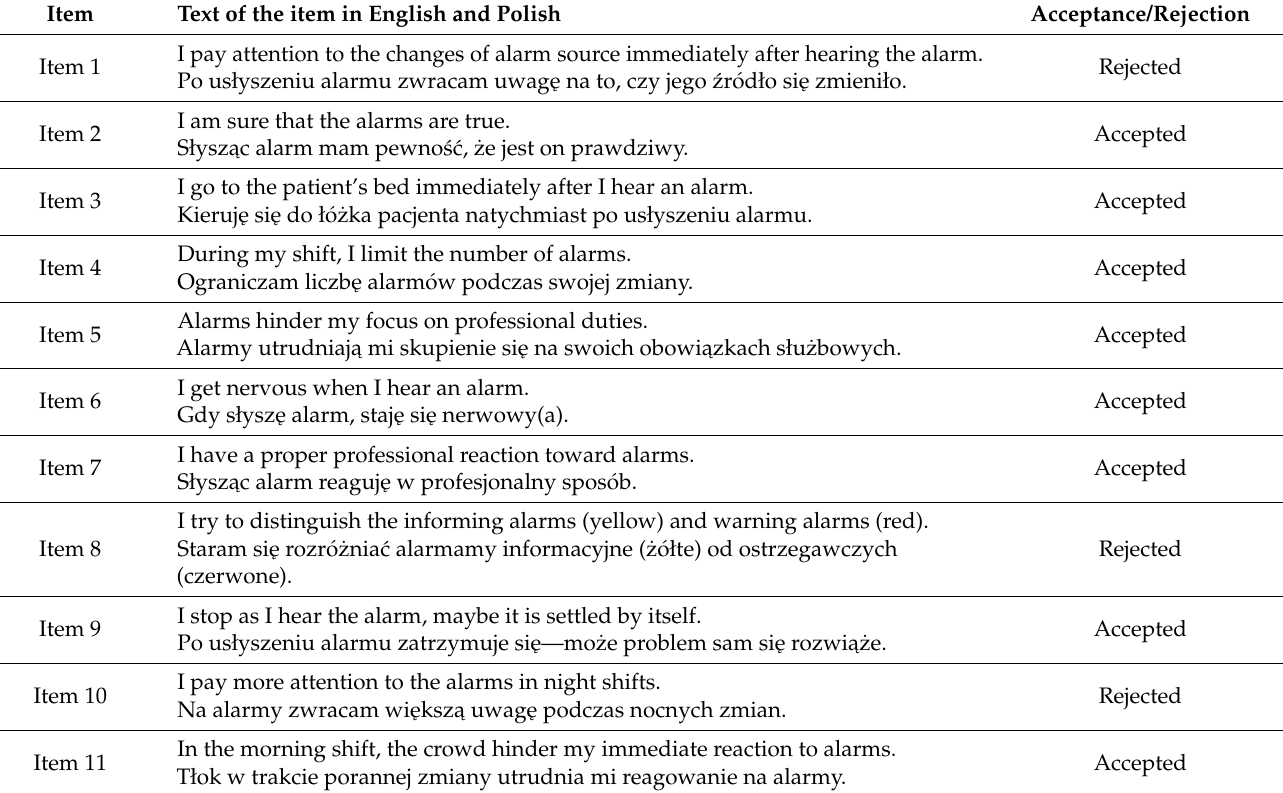
Table 1. Individual items from the Alarm Fatigue Assessment